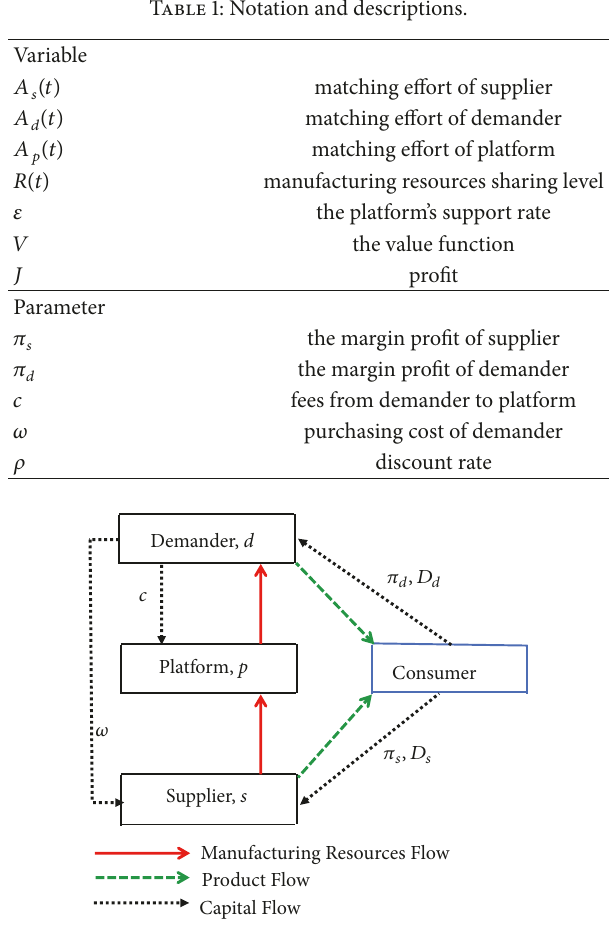
Figure 2: Channel structure of the sharing supply